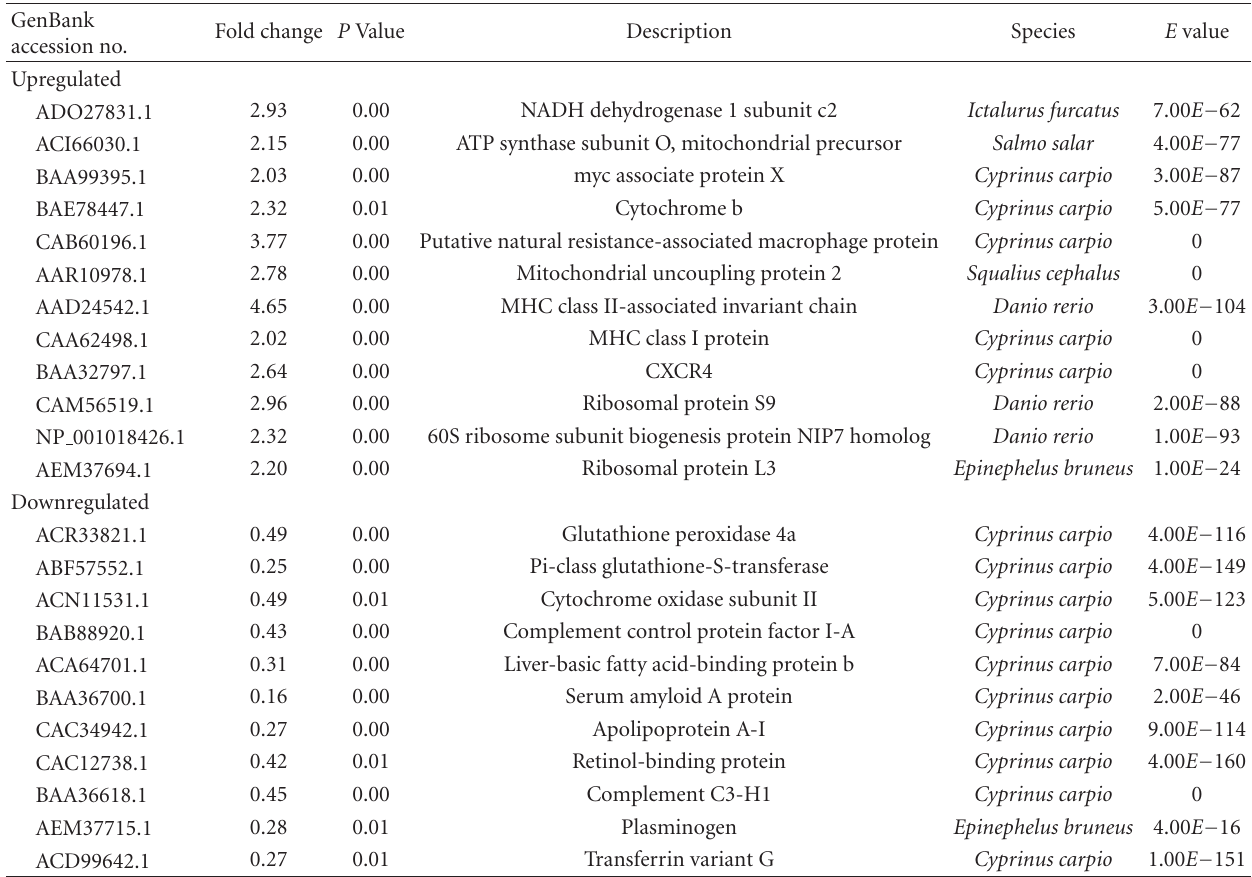
Table 4: Genes were altered 2-fold in response to Ag-NPs in the common carp, which were modified from our previous study [18] ( P <